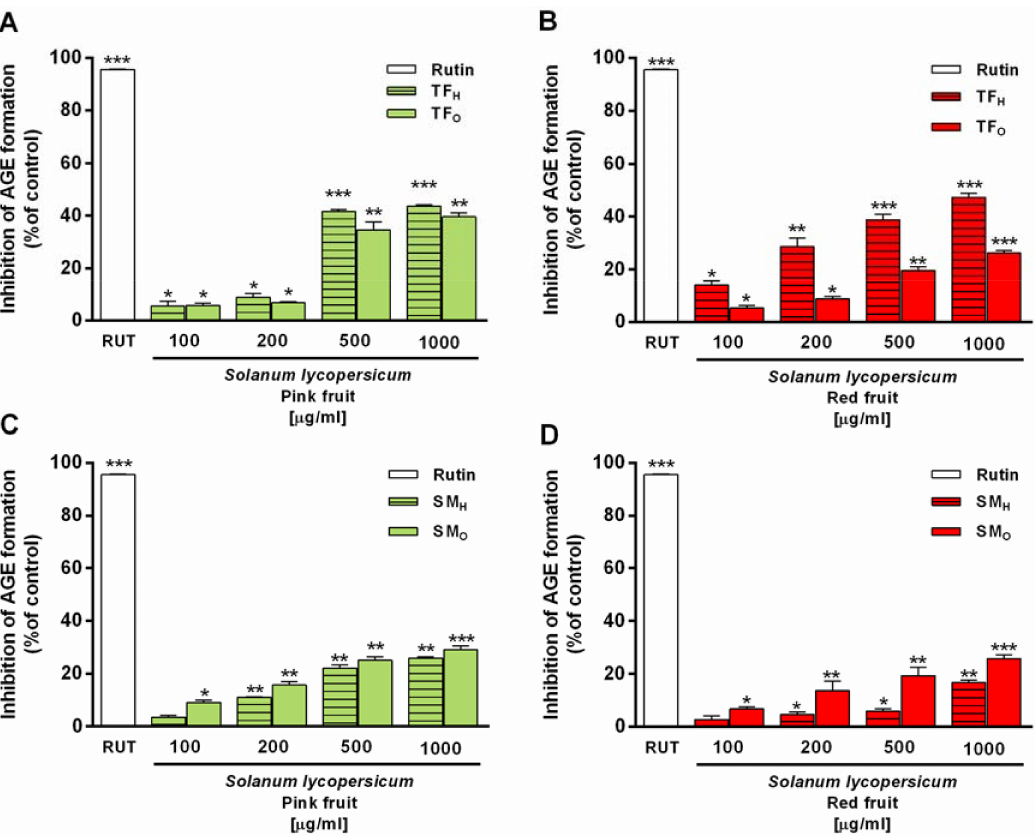
Figure 6. Inhibition of formation of advanced glycation end-products (AGE) induced by organic (O) and hydroalcoholic (H) extracts from Solanum lycopersicum var. ( A ) TF P , ( B ) TF R , ( C ) SM P , ( D ) SM R , and the positive control rutin [200 µ g mL − 1 ]. RUT, rutin, TF H , TF O , SM H , SM O . Each value represents mean ± SEM ( n = 6). * p < 0.05, ** p < 0.01, and *** p < 0.01, represent a statistically significant